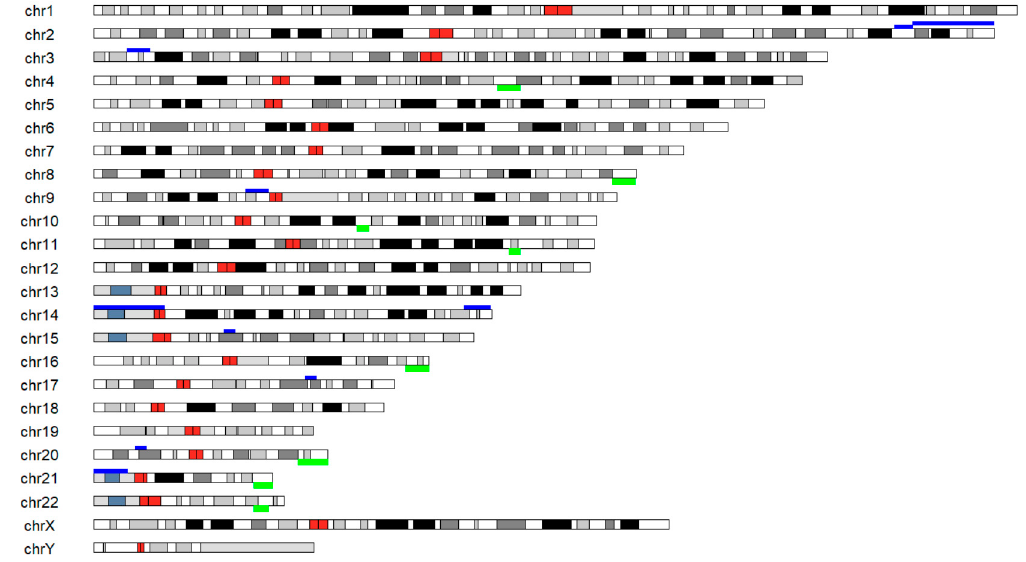
Figure 4. Karyogram representing clinically relevant autosomal alterations identified based on the NGS analysis of the gDNA content from the culture media of the aborted embryos. Dark red bands showing the centromeres, green bands above the chromosomes are indication gains and dark blue bands showing losses.